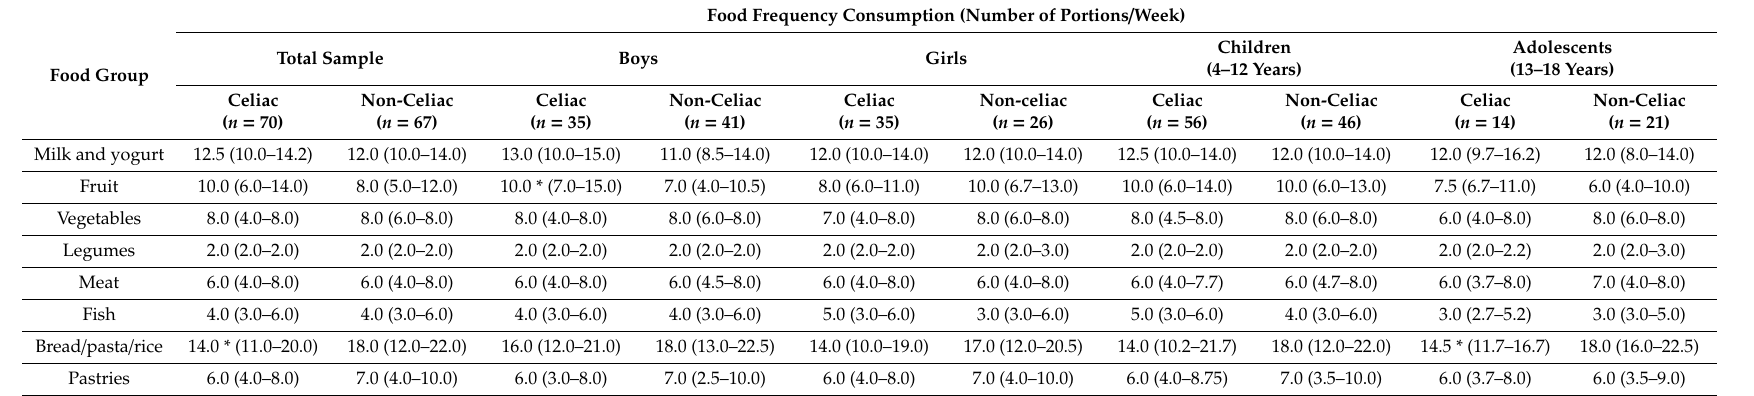
Table 2. Food frequency consumption in celiac and non-celiac children and adolescents, expressed as a number of portions per week.